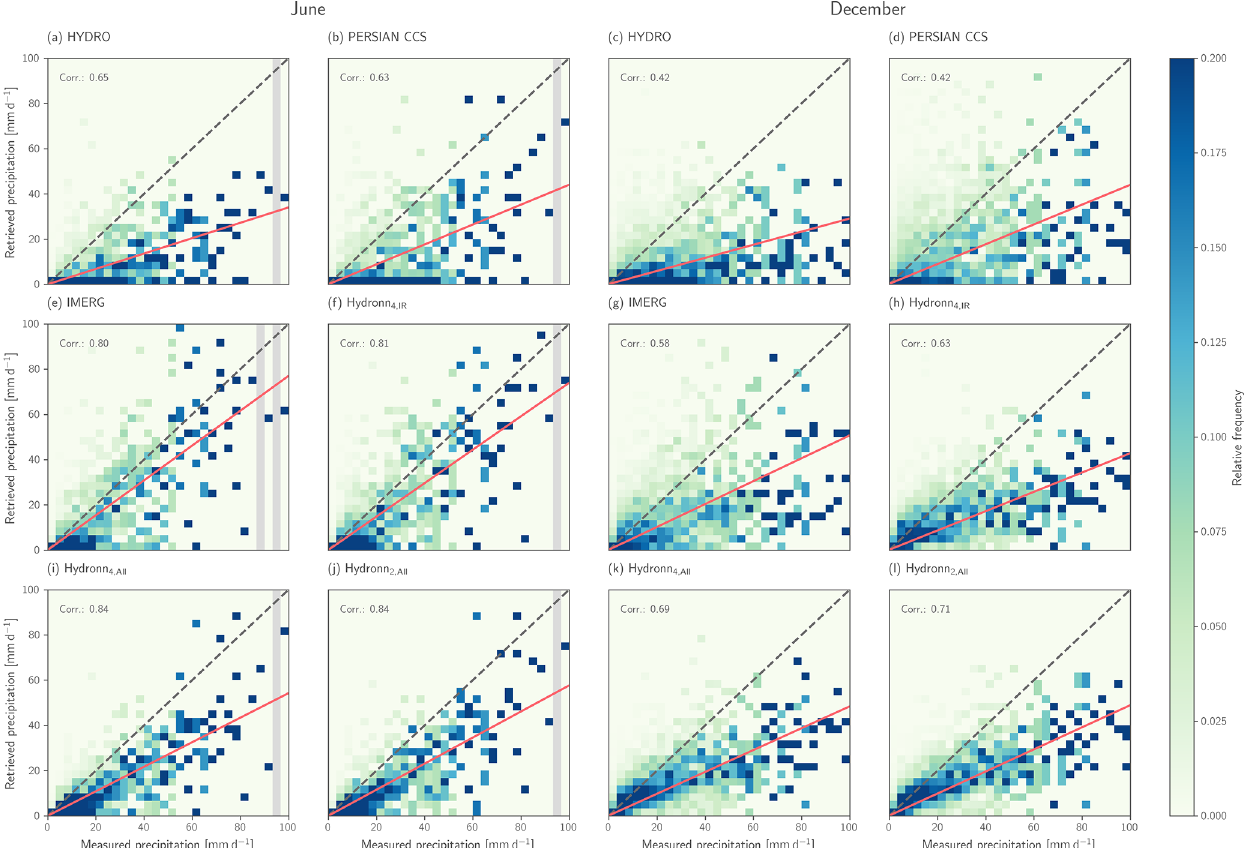
Figure 11. Scatter plots of gauge measurements against retrieved daily accumulations for HYDRO, PERSIANN-CCS, IMERG, and the three Hydronn configurations. The first two columns show the results for June 2020. The third and fourth columns show the results for December 2020. Frequencies have been normalized column-wise to improve the visibility of heavy precipitation